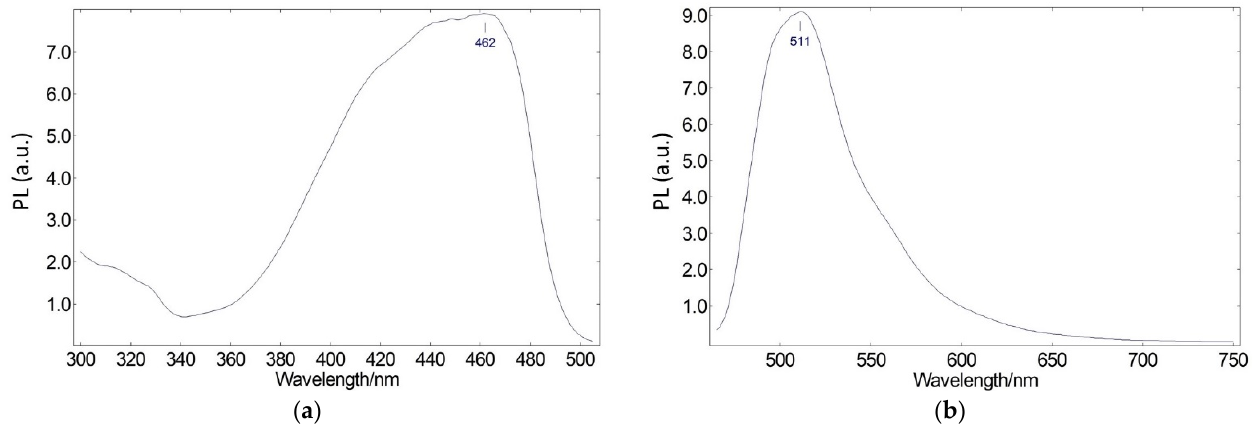
Figure 6. ( a ) Photoluminescence excitation spectrum (peaking at 462 nm) and ( b ) photoluminescence emission spectrum (peaking at 511 nm) of Coumarin 6 green-emitting converter embedded in an EVA polymer.